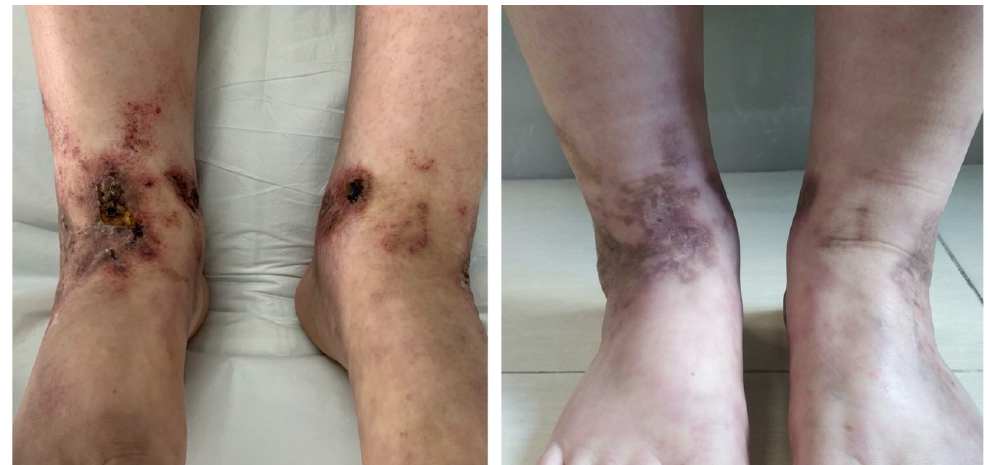
Figure 3. Clinical images of patient 3 before and 6 months after adalimumab treatment.